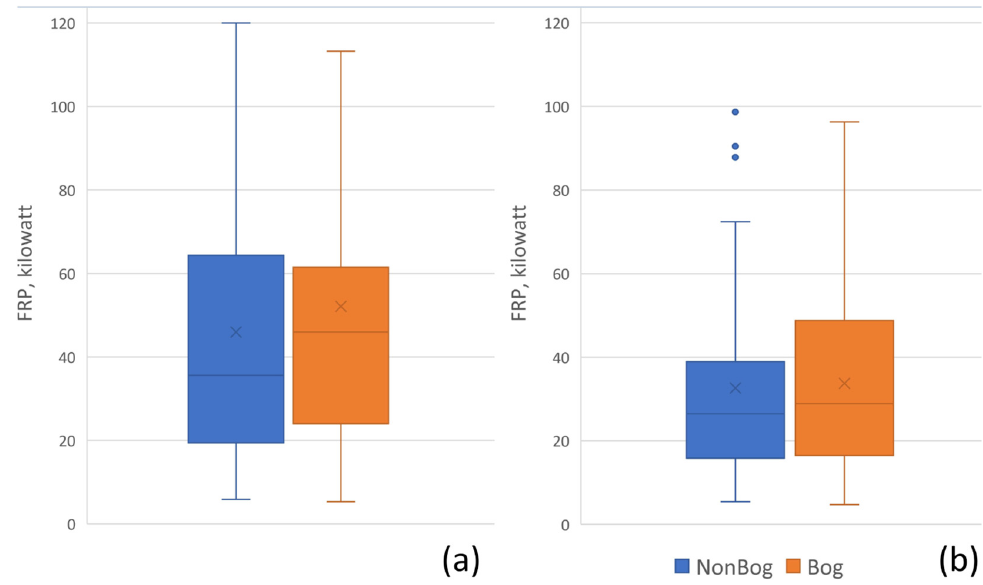
Figure 6. Boxplot with average annual FRP values in peatlands and other areas: ( a )—Tokma area; ( b )—Khanda area.